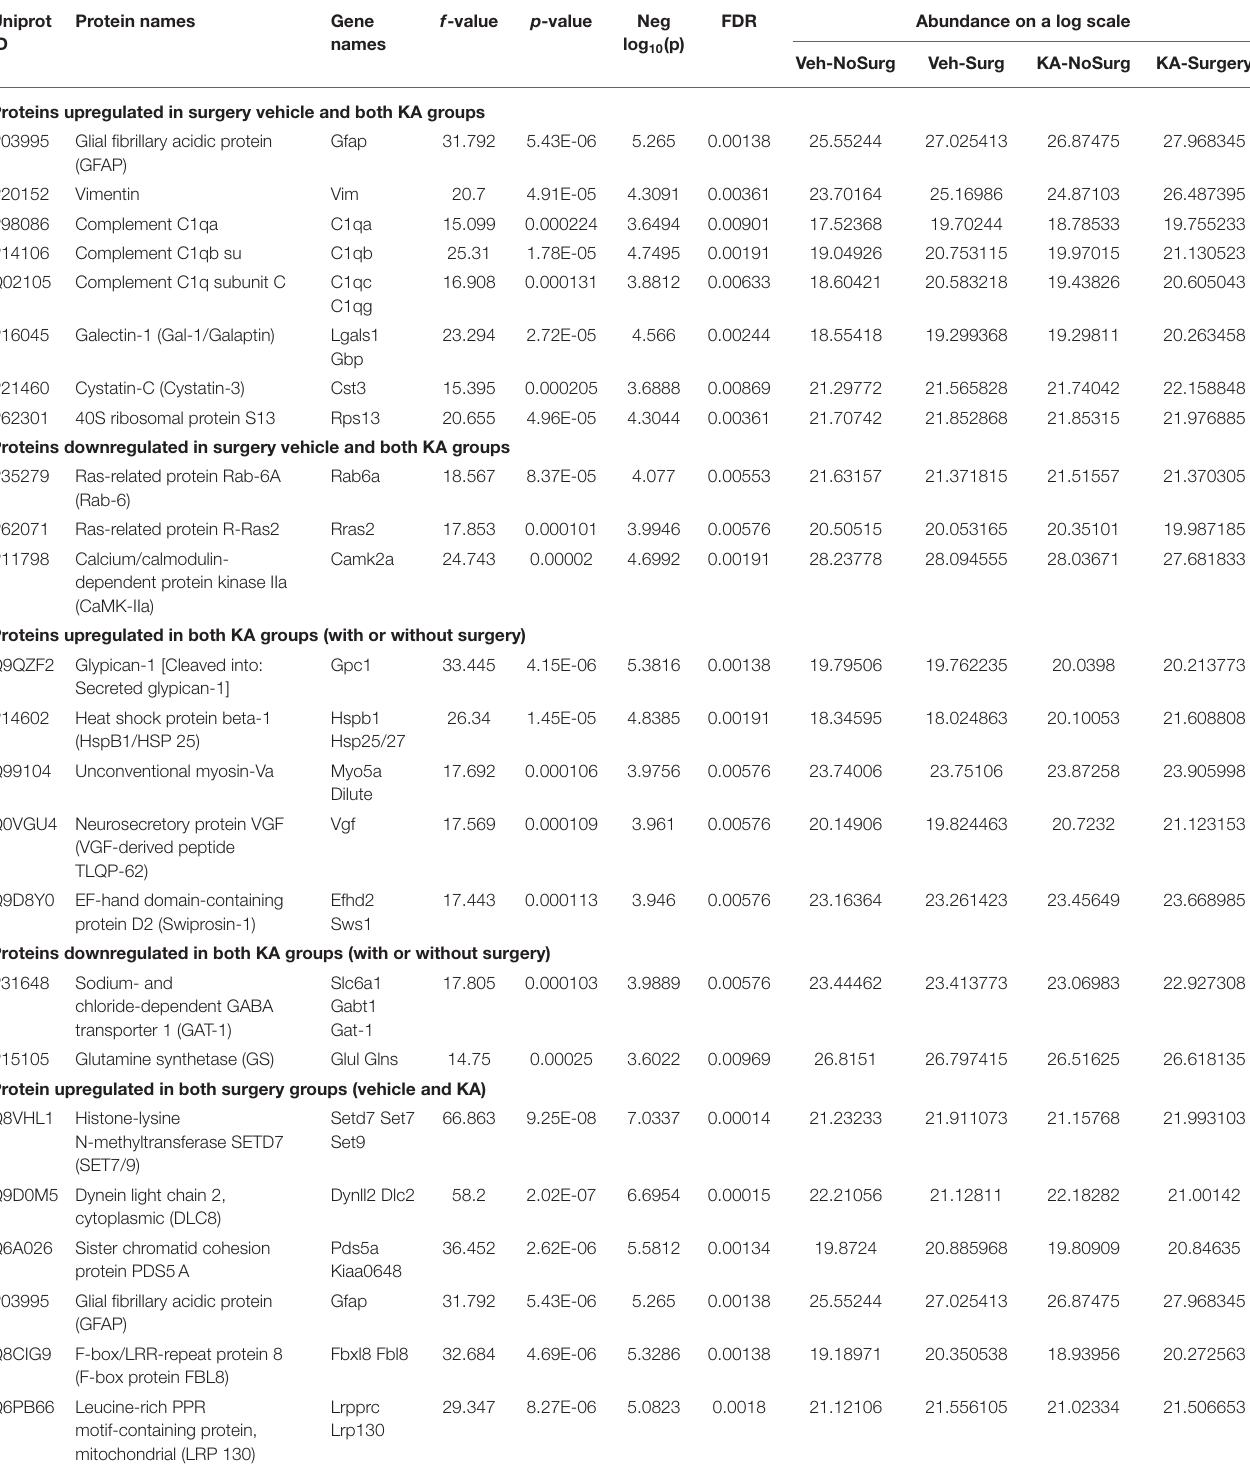
TABLE 2 | The impact of intracerebral electrode implants (surgery) and KA or vehicle on altered protein expression in the hippocampus. Uniprot